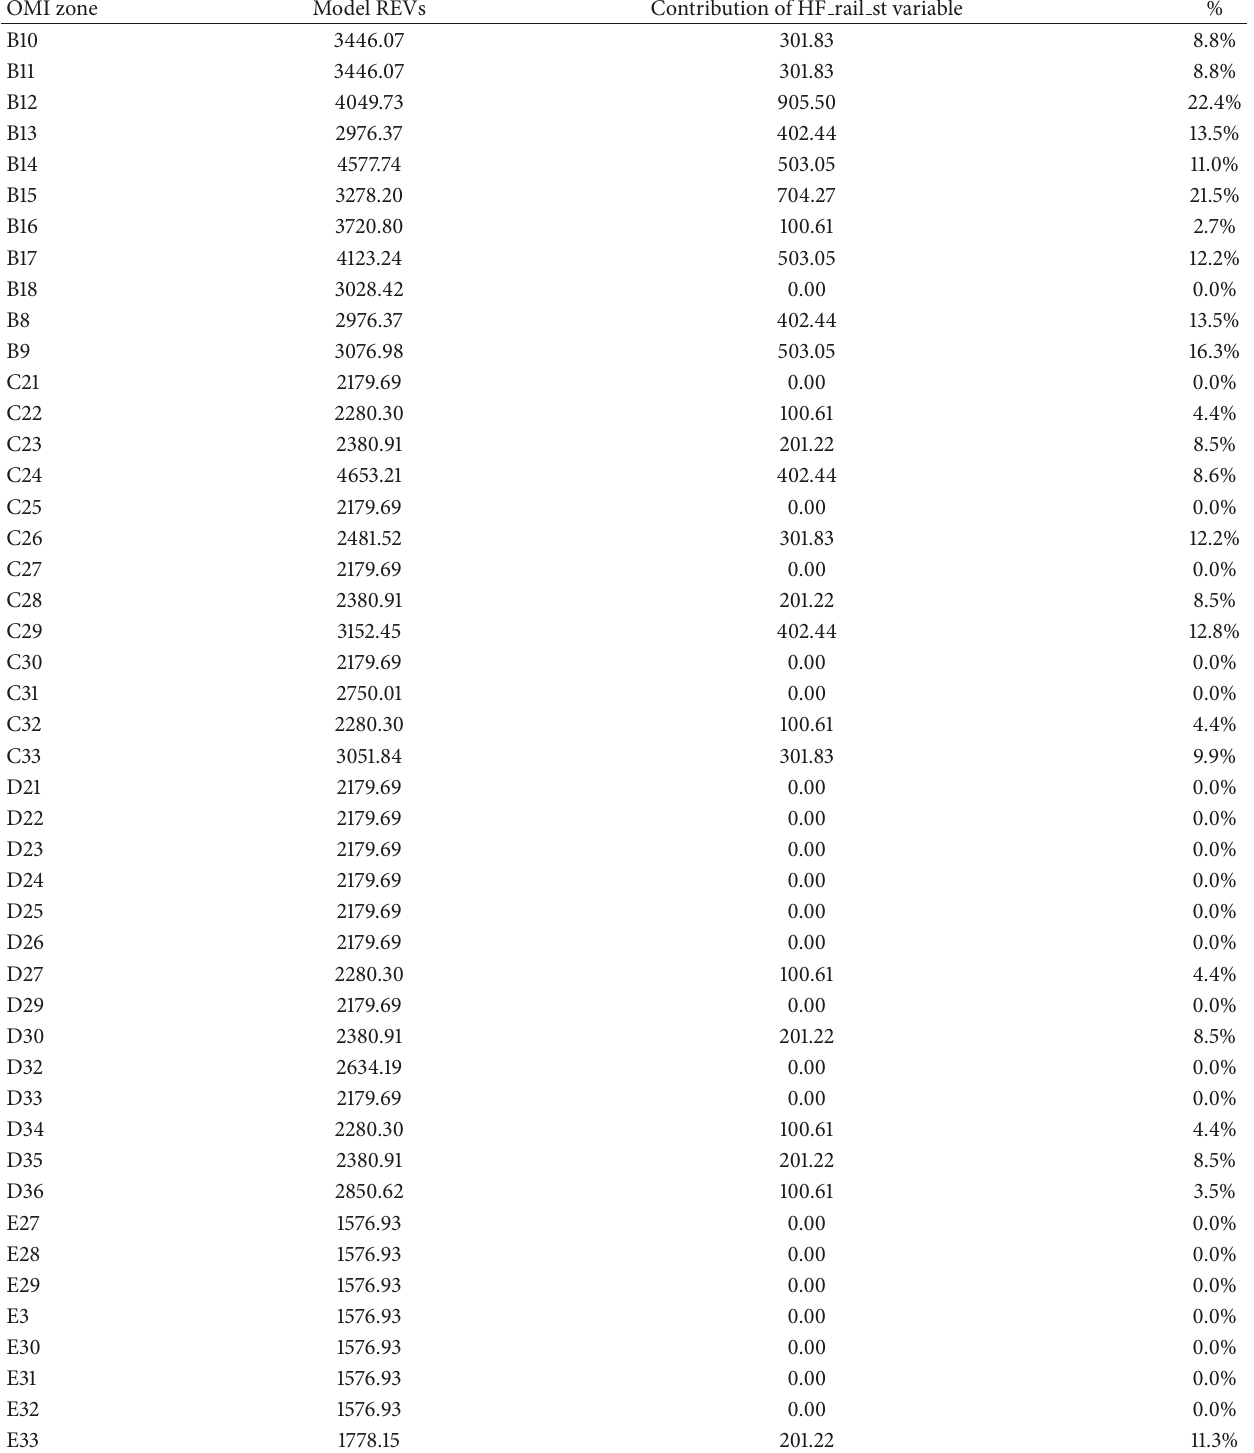
Table 9: Contribution of high-frequency rail stations to real estate